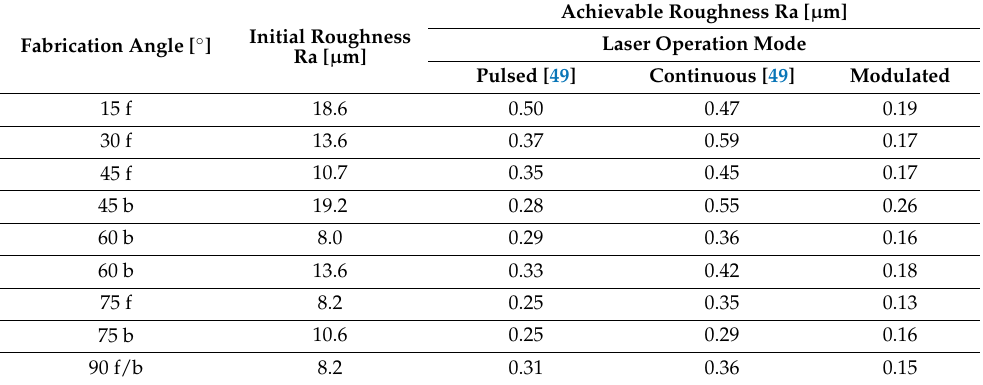
Table 6. Achieved roughness Ra at pulsed [49], continuous [49] and modulated laser operation modes depending on the fabrication angle and initial roughness, measured in sample vertical direction